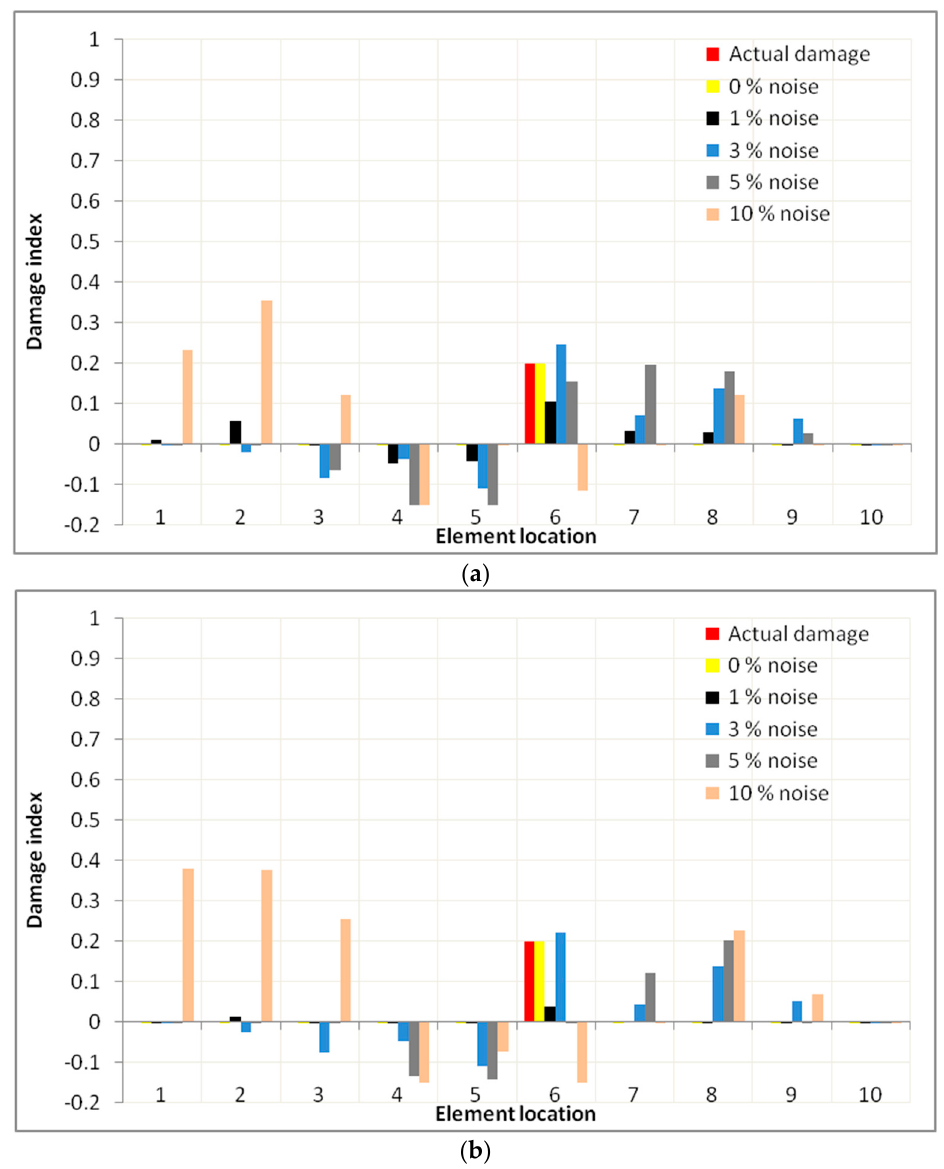
Figure 8. Damage distribution for Case 1 using Objective Function III with regularization for ( a ) noise both in frequency and mode shapes and ( b ) noise in mode shapes only.